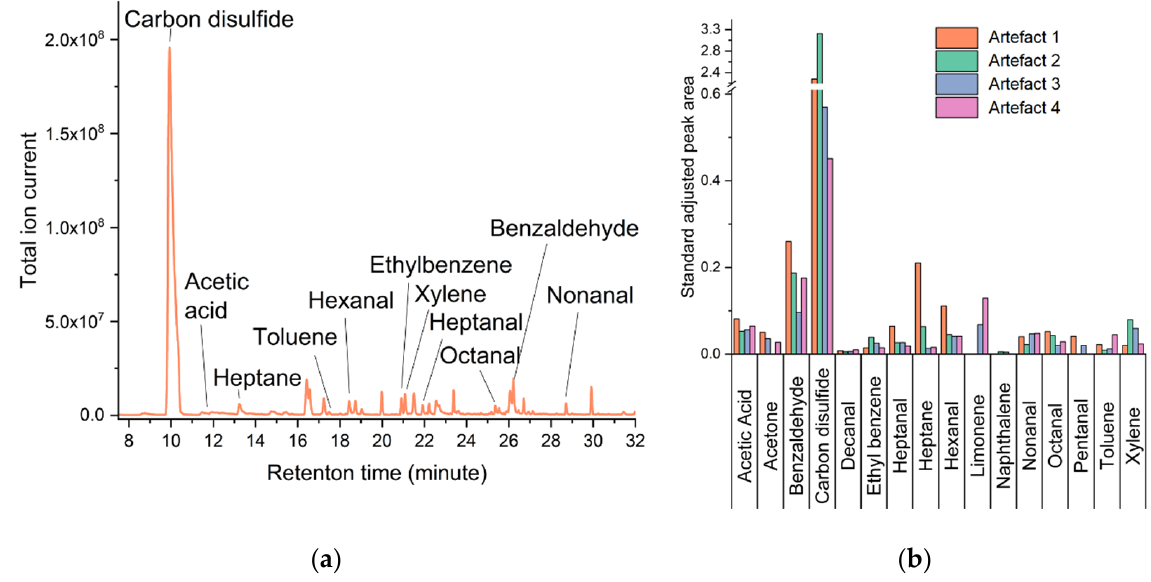
Figure 3. Compounds detected by HS ‐ SPME ‐ GC–MS analysis from Mary Rose wooden artefacts after 48 days inside a Tedlar bag. Right, ( a ) Chromatogram of Artefact 1 (87A0068). Left, ( b ) standard adjusted peak areas of Artefacts 1 to 4.